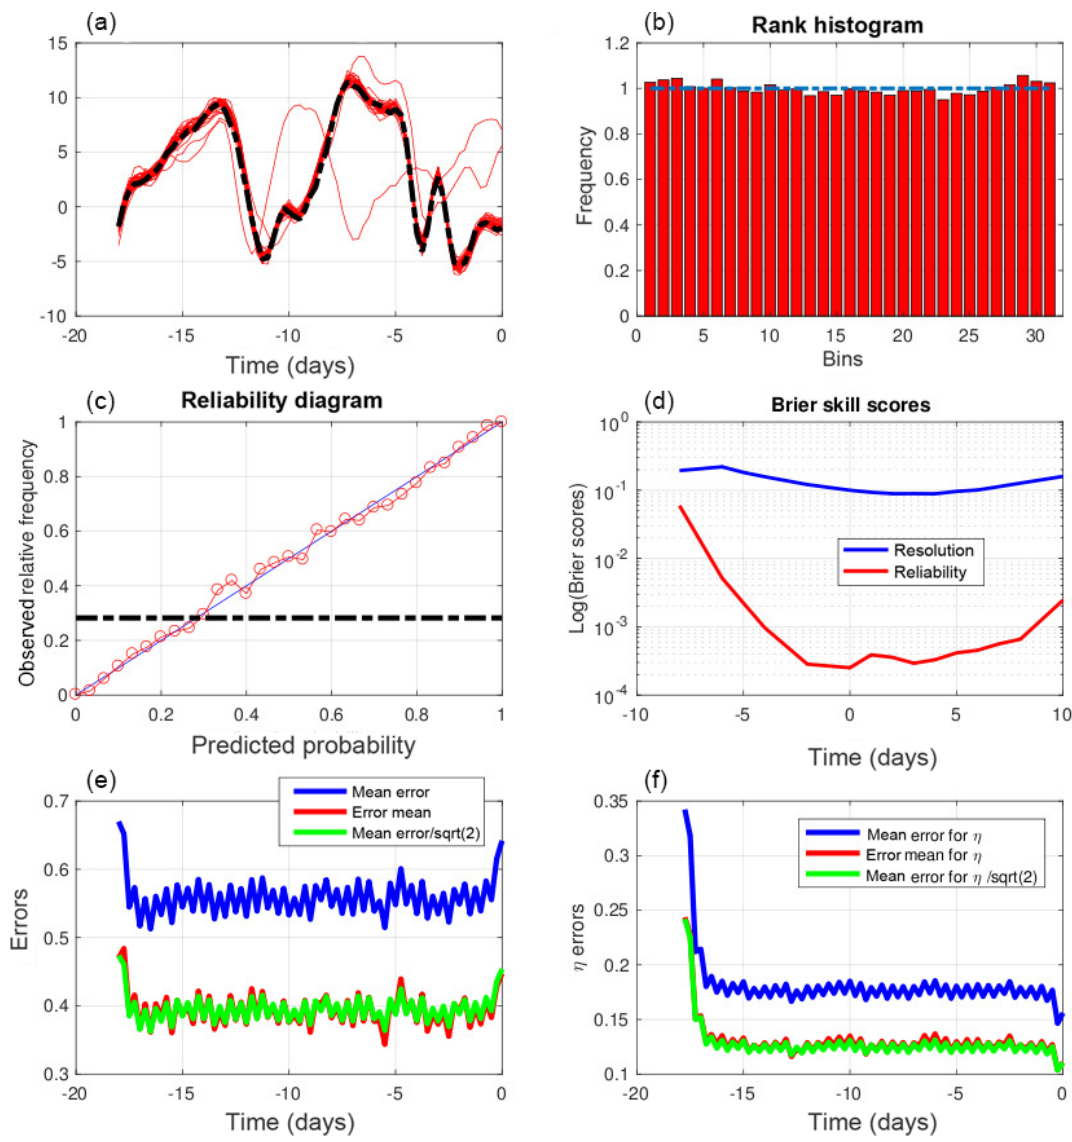
Figure 9. Diagnostics of weak-constraint variational assimilations performed over 18-day assimilation windows. (a) Truth (dashed curves) and minimizing solutions (red curves) as functions of time at one grid point over one assimilation window. (b) Rank histogram for the variable x over all grid points and ensemble assimilations. (c) Reliability diagram for the event E = { x > 1 . 02 } , which occurs with frequency 0.27 (dashed–dotted horizontal curve), built over all grid points and ensemble assimilations. (d) Components of the Brier score (same format as in the bottom-left panel of Fig. 1). (e, f) RMS estimation error on the state variable x and on the model noise b ( e and f respectively), as functions of time along the assimilation windows. Blue curves: average RMS error in the individual minimizations. Red curves: average √ 2 to the blue RMS error in the mean of the ensembles. The green curves are in the ratio 1 /